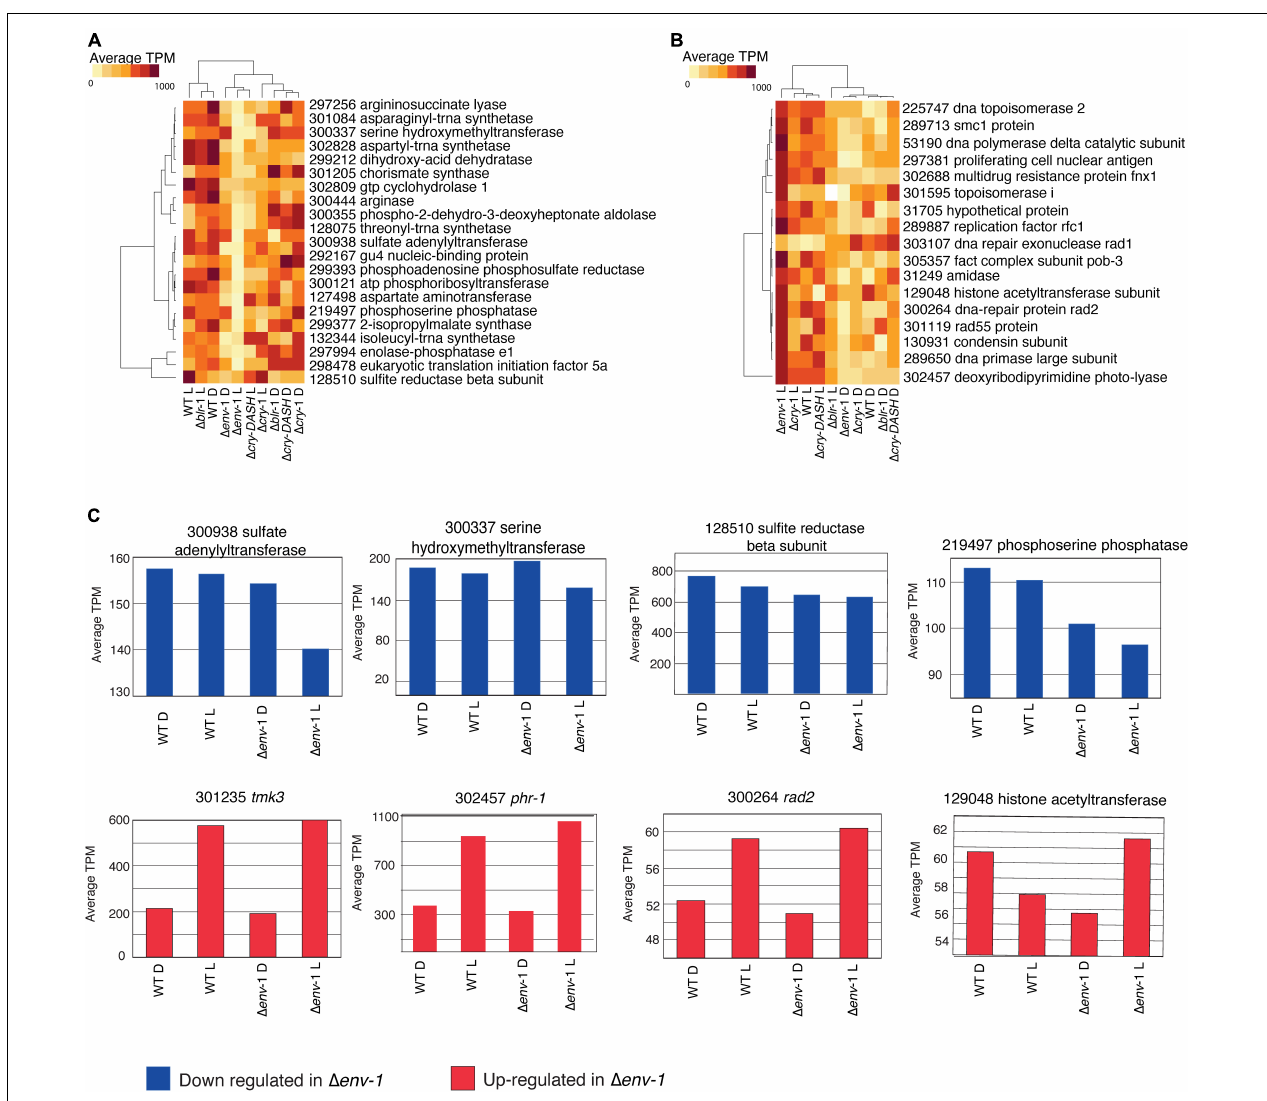
FIGURE 5 | Expression of genes related to amino acid metabolism and DNA repair are affected by the ENVOY mutation. (A) Expression profile of the genes contained in the category of cellular amino acid metabolic process, which have a repressive behavior in (cid:49) env- 1 in response to light. (B) Expression profile of the genes contained in the category of DNA metabolic process, which have an induction behavior in (cid:49) env -1 in response to light. (A,B) Colors indicate the average counts per million. (C) Bar graphs of the average counts per million of genes repressed and induced in response to light in the WT strain, which show a drastic change in the (cid:49) env -1. Blue bars represent down-regulated genes and red bars up-regulated